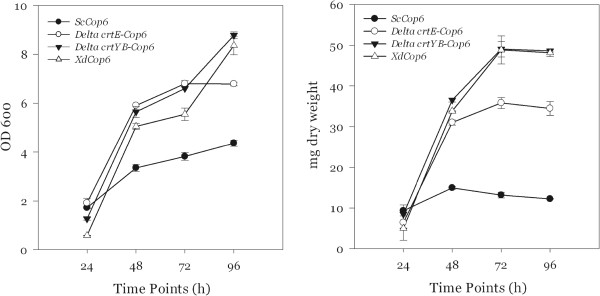
OD600 and cell dry weight of ScCop6, ΔE-Cop6, ΔYB-Cop6 and XdCop6 in 10 ml of minimal medium.